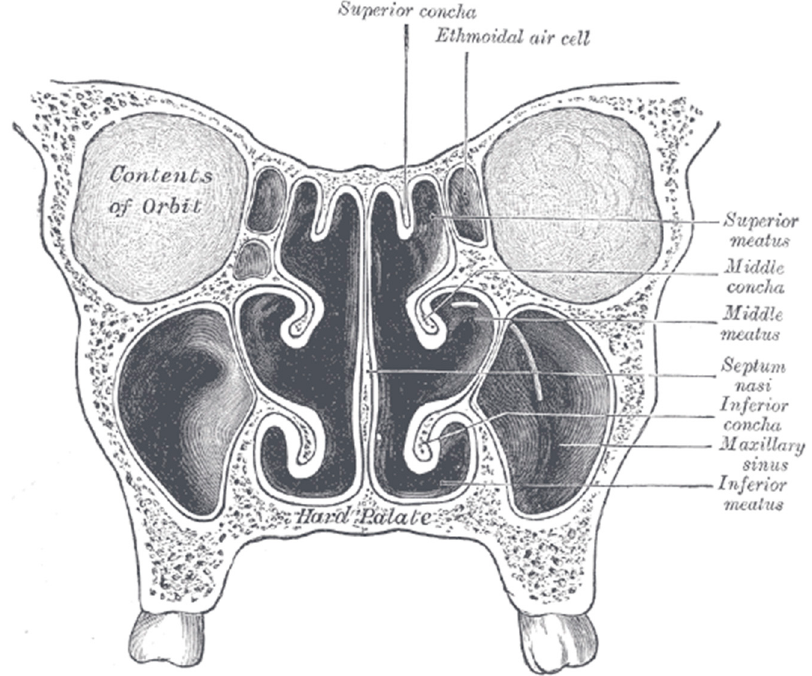
Figure 2. Coronal section of nasal cavities. Source Lewis (1918) Gray’s Anatomy 20th edition